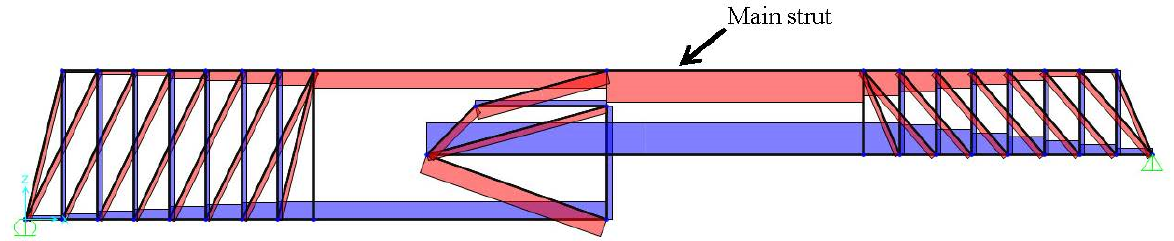
Figure 22. The force diagram of the struts and ties of B1.